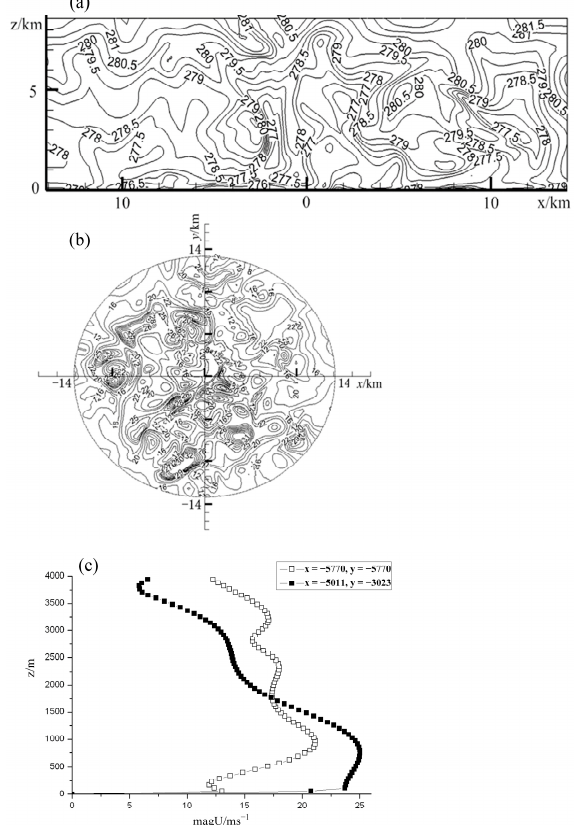
Figure 2. Air flows field at the full development stage ( a ) Air temperature in the central vertical plane z-x; ( b ) Horizontal velocity contours (m s − 1 ) in the x-y plane, z = 1000 m. The appearance of many vortices with different diameters would generate “waves” forming several “lobes” that appear at the front edge of a LSS. ( c ) The resultant wind velocity profiles at different altitude of two positions (x = − 5770 m, y = − 5770 m, and x = − 5011 m, y = − 3023 m) around the cold pool center. The remarkable feature of these velocity profiles is their “lobes” shape, which contributes to dust uplift from the surface (the simulation was conducted using RANS model by He, Y., 2020.).